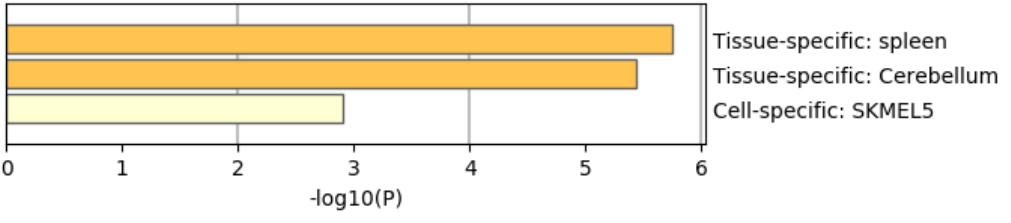
Figure 16. Summary of enrichment of the PaGenBase category of Metascape when 962 protein-coding genes included in 1447 genomic regions selected by categorical regression are considered.